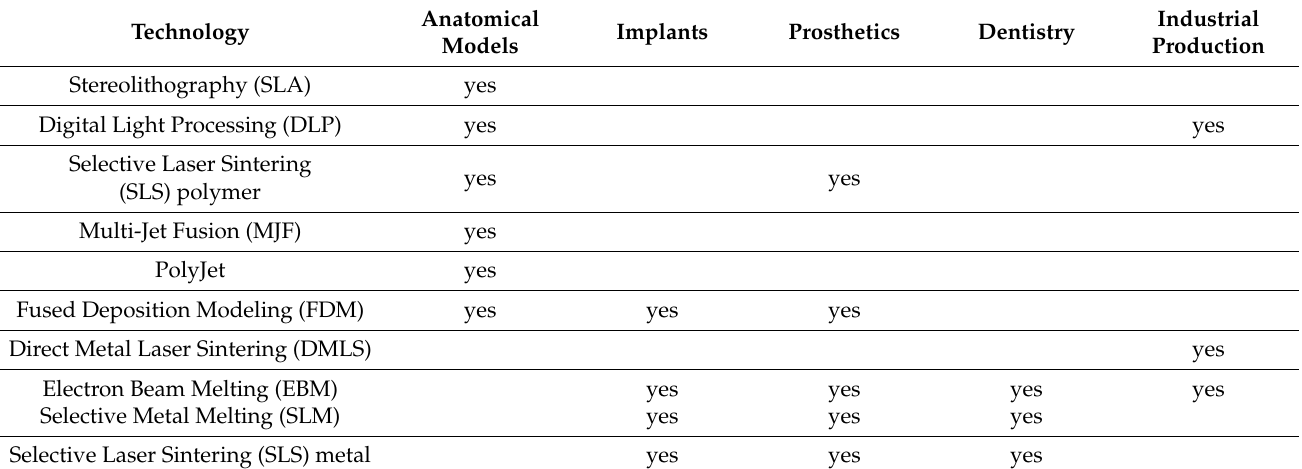
Table 2. Uses of various 3D printing